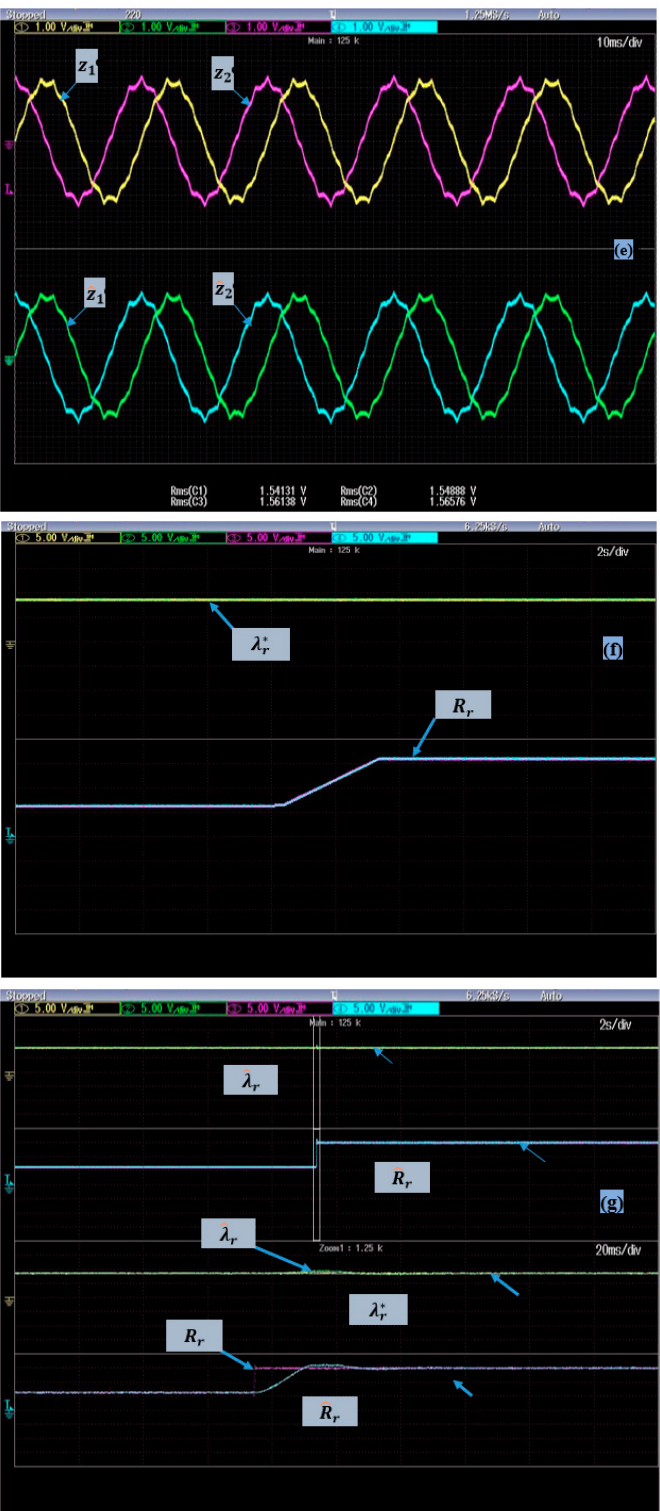
Figure 3. Real time results of sensorless control of five-phase IM drive. (a) Speed, (b) torque, (c) Stator currents (complete view), (d) Rotor flux (Reference and estimated signals), (e) Zoomed view of stator currents (actual and estimated), (f) Rotor flux and rotor resistance variation, (g) Rotor flux dynamics under rotor resistance variation.